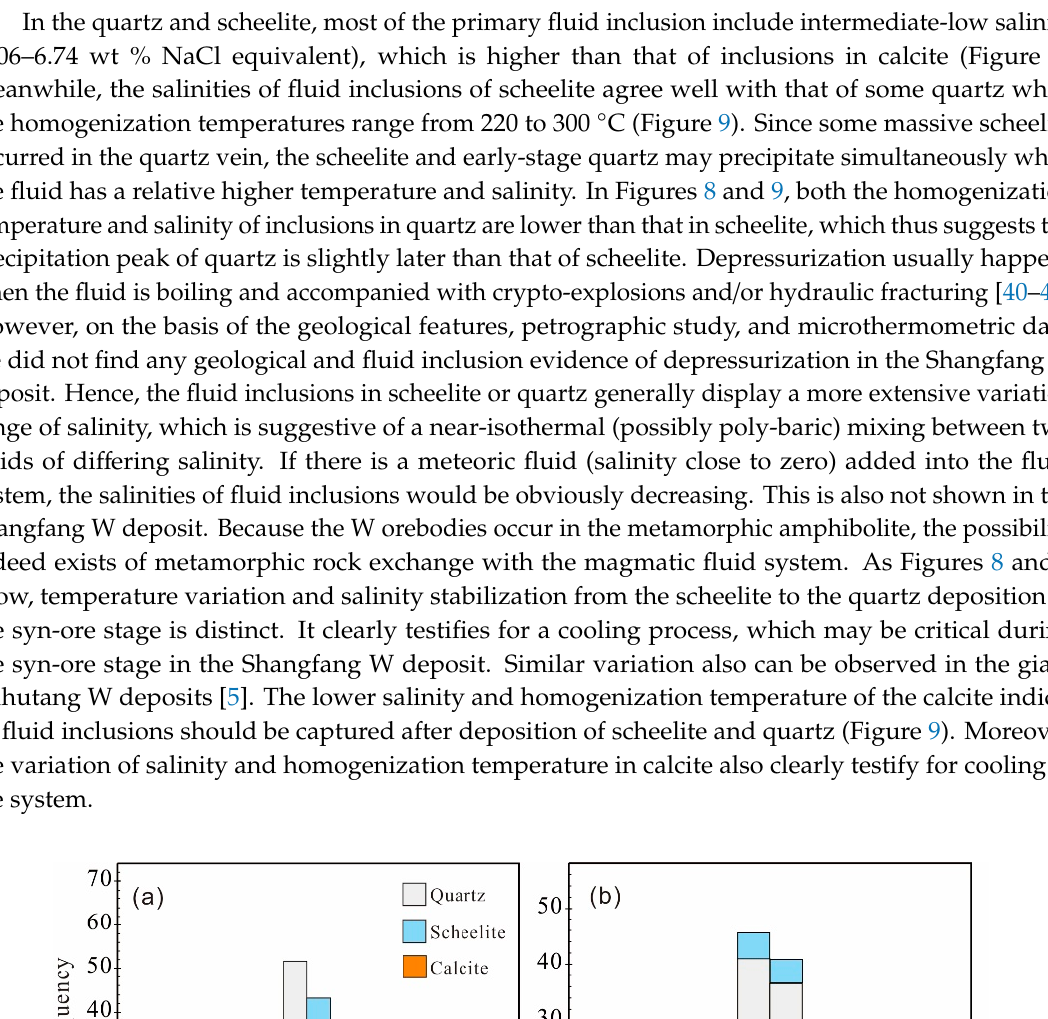
Figure 9. Covariation between homogenization temperature and salinity of fluid inclusions showing the evolution of the ore ‐ forming fluids in the Shangfang W deposit. 6.2. Origin of Ore ‐ Forming Fluids It is acceptable that oxygen and hydrogen isotope compositions of hydrothermal quartz are useful for tracking the source of hydrothermal fluids. Given that the actual temperature of fluid inclusions (> − 300 °C) is higher than the homogenization temperature under atmospheric conditions, the oxygen isotopic compositions are respectively calculated against 400, − 350, and − 300 °C, as shown in Figure 10. The calculated results of oxygen and hydrogen isotope compositions in the Shangfang W deposit are all distributed in the variation range of ore fluids for polymetallic deposits in the coastal South China Block. When the temperature is higher than 300 °C, most of the δ 18 O results are distributed within the area of primary magmatic water and the metamorphic water. The pieces of